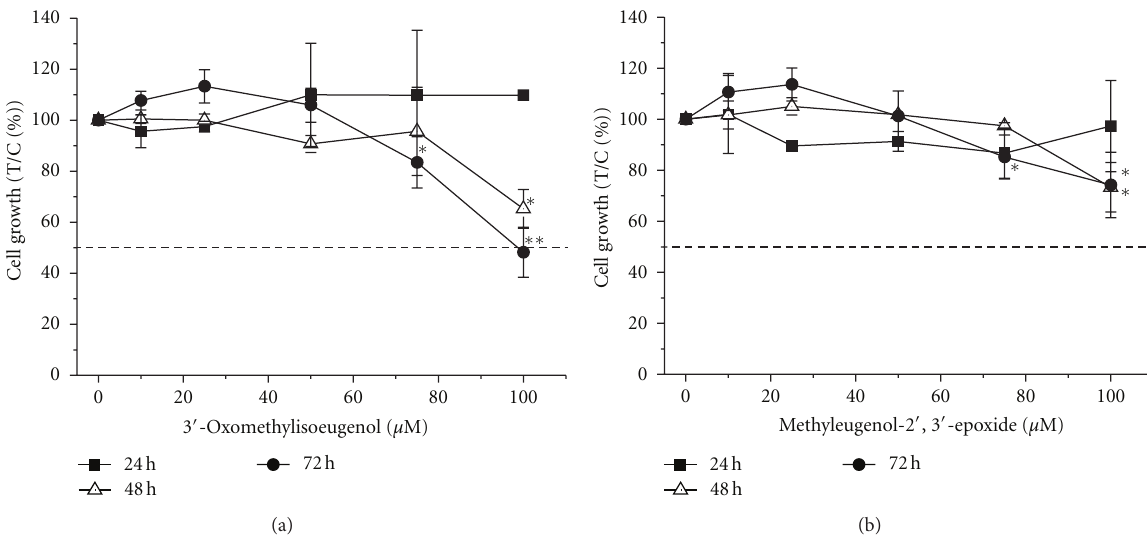
Figure 2: Inhibition of tumor cell growth in vitro by (a) 3 󸀠 -oxomethylisoeugenol (3 󸀠 -OXO-ME) and (b) methyleugenol-2 󸀠 ,3 󸀠 -epoxide (MEE). Growth inhibition was determined using the sulforhodamine B assay according to Kern et al. [32]. HT29 cells were incubated with the respective compound for 24–72 h. Growth inhibition was calculated as survival of treated cells over control cells (treated with the vehicle 0.5% DMSO) × 100 [T/C%]. The values given are mean ± SD (standard deviation) of at least four independent experiments, each performed in quadruplicate. The significances indicated were calculated in relation to the solvent control DMSO 0.5% v/v (Student’s 𝑡 -test: ∗ 𝑃 ≤ 0.05 ; ∗∗ 𝑃 ≤ 0.01 ).